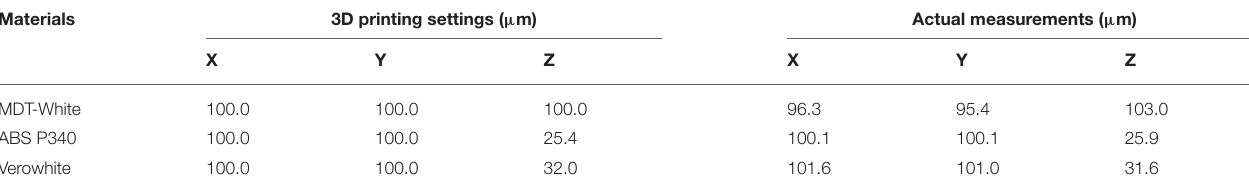
TABLE 2 | Comparison of physical dimensions of digitized and actual 3D printed phantom